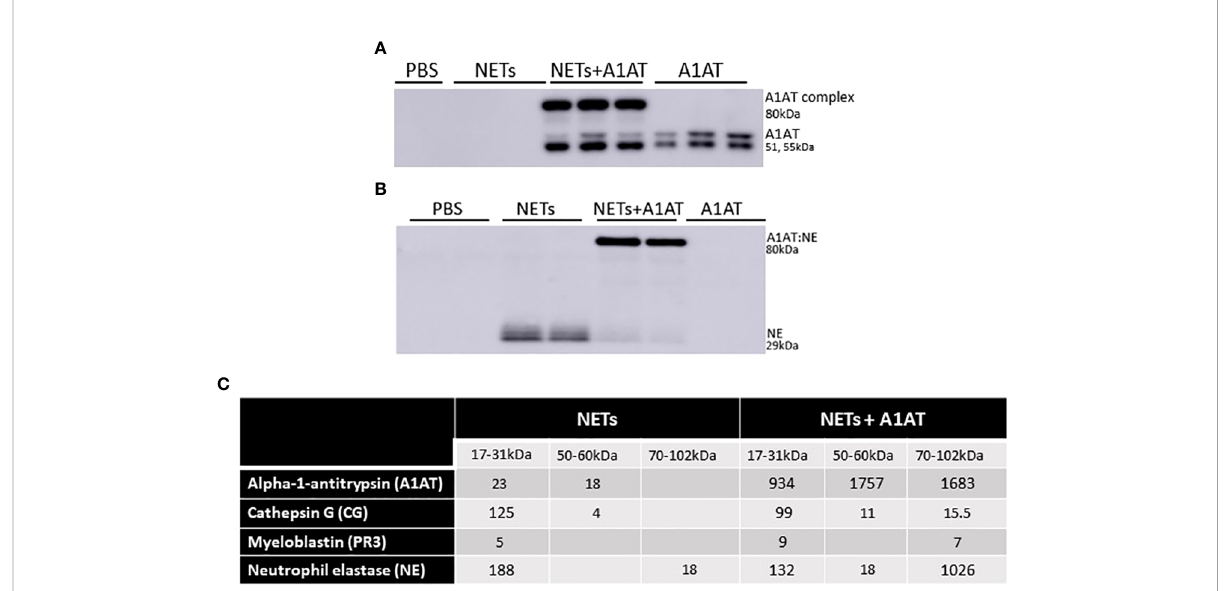
FIGURE 7 Alpha-1 antitrypsin binds serine proteases in NET exposed HBE. HBE grown at ALI were exposed to PBS, 5µg/ml NETs, NETs + A1AT or A1AT for 18h in triplicate wells. (A) Western blot of HBE apical supernatants probed with A1AT antibody demonstrate the colocalization of A1AT (51- 55kDa) with a 29kDa protein in NETs. (B) Western blot of HBE apical supernatants probed with NE antibody demonstrate the colocalization of A1AT with NE (29kDa) in NETs forming an 80kDa complex. (C) Representative mass spectrometry results from bands shown on western blot in 7A & B con fi rm that HBE exposed to NETs have peptide spectral matches (PSMs) that correspond to CG, PR3, and NE at the expected 17-31kDa sizes. HBE exposed to NETs + A1AT demonstrate PSMs corresponding to NE, CG, PR3 and A1AT at 70-102kDa indicating formation of a A1AT: NE, A1AT:CG and A1AT:PR3 complexes (mass spec run=3, HBE donors=2, NET